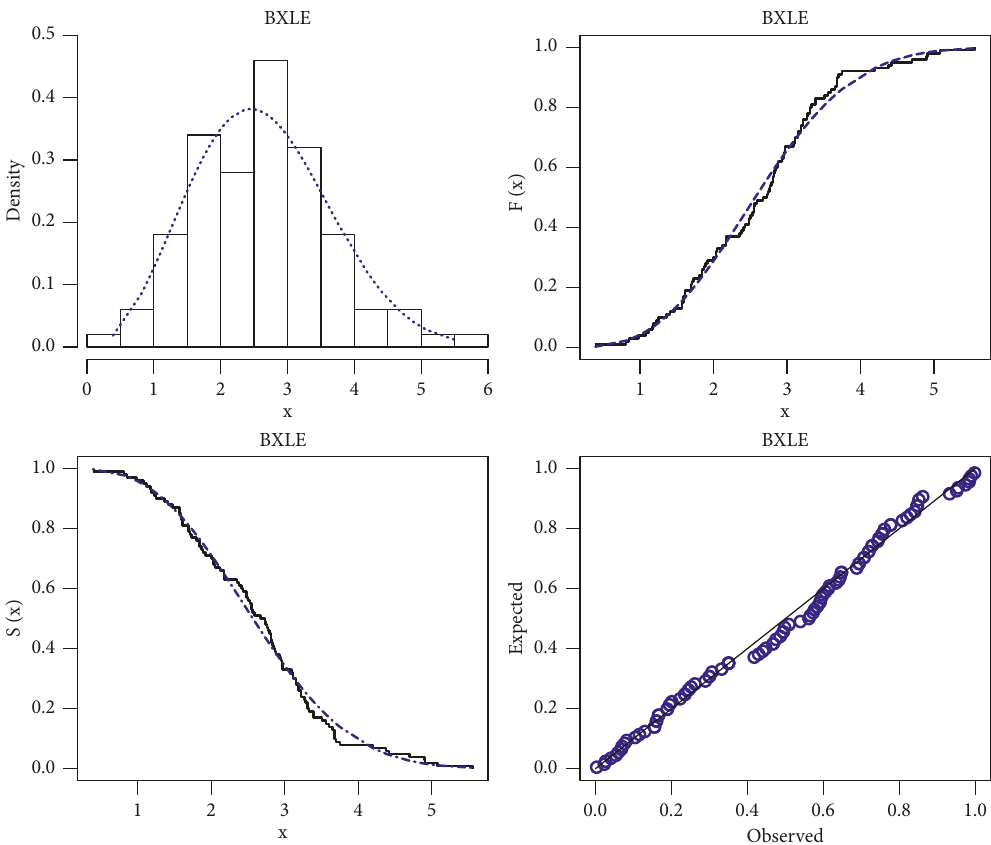
Figure 4: The fitted BXLE PDF, CDF, SF, and P-P plots for second